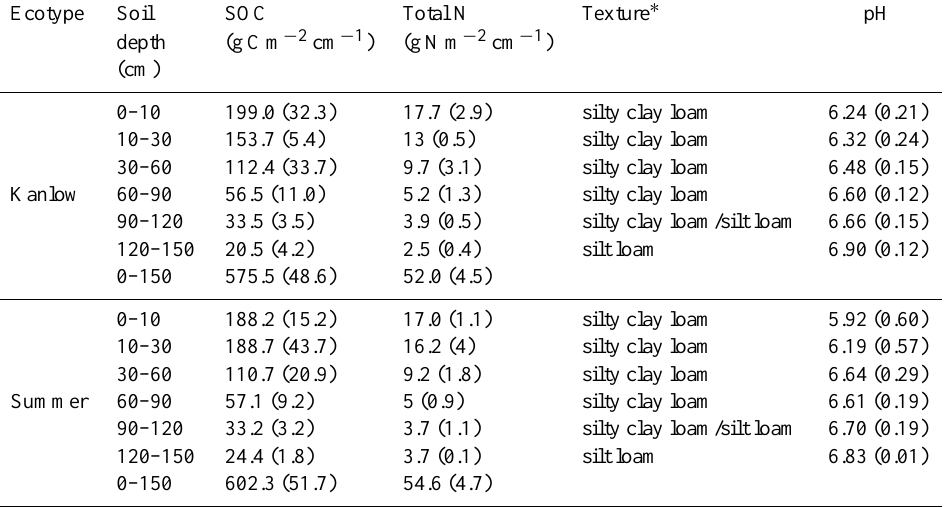
Table 1. Soil properties (C and N stocks, texture, pH) for switchgrass lowland (Kanlow) ecotype and upland ecotype (Summer) down to 150cm. Values in parentheses are standard